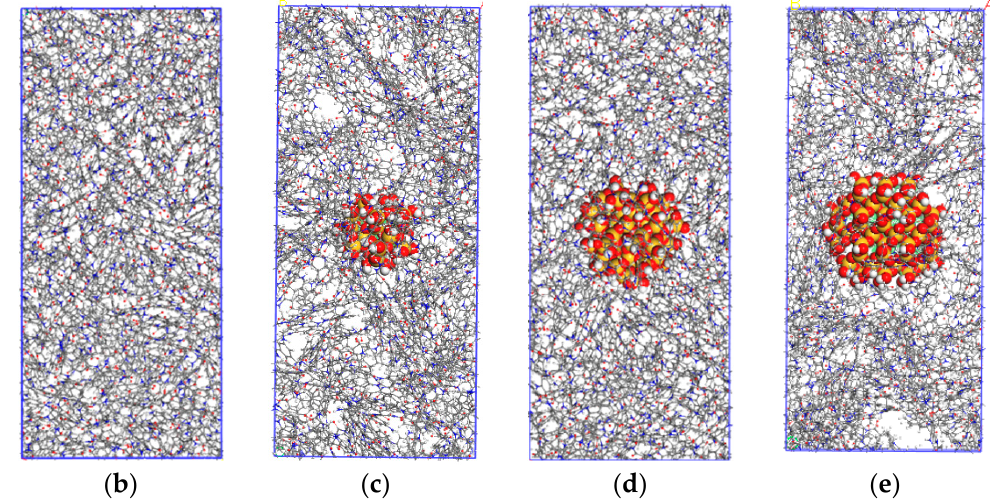
Figure 2. Establishment of thermal conductivity model and temperature distribution ( a ) The temperature distribution of the model; ( b ) PMIA model for heat conduction calculation; ( c ) SiO 2 /PMIA model for heat conduction calculation (4 Å); ( d ) SiO 2 /PMIA model for heat conduction calculation (8 Å); ( e ) SiO 2 /PMIA model for heat conduction calculation (12 Å).